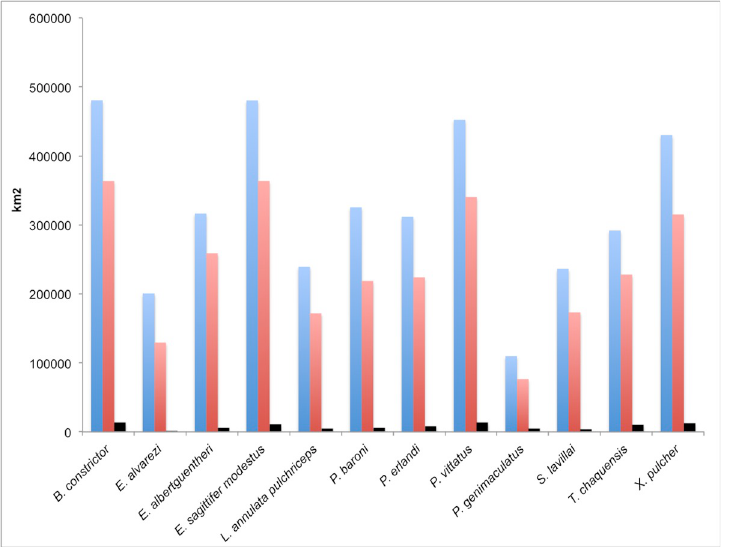
Fig 3. Potential distribution areas (in km 2 ) of snake species in Dry Chaco forest. Blue bars: distributional range predicted for each snake species in the Dry Chaco forest; Red bars: distributional range predicted for species in Argentinian Dry Chaco forest considering habitat loss/deforestation; Black bars: distributional range predicted within protected areas.